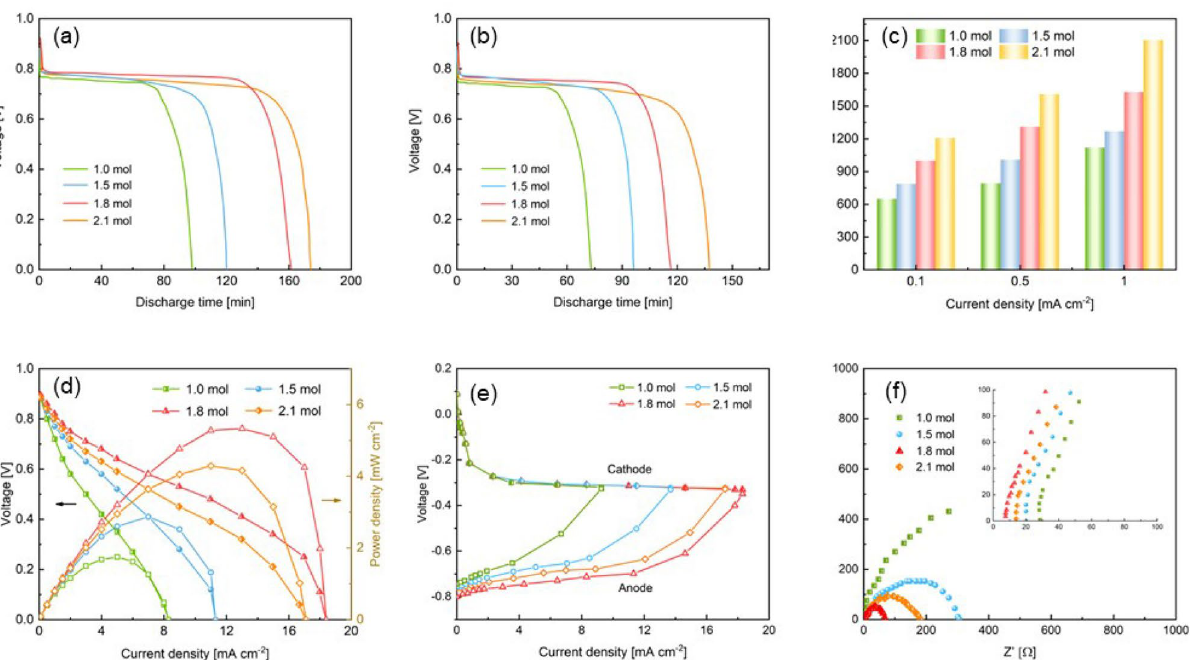
Figure 5. The discharge profiles of the Al–air battery at ( a ) 0.1 and ( b ) 0.5 mA cm −2 . ( c ) Specific capacity of the Al–air batteries with electrolytes of different NaCl content. ( d ) The polarization curves and power-density profiles of the Al–air batteries. ( e ) Single electrode polarization. ( f ) EIS analysis of the Al–air battery.